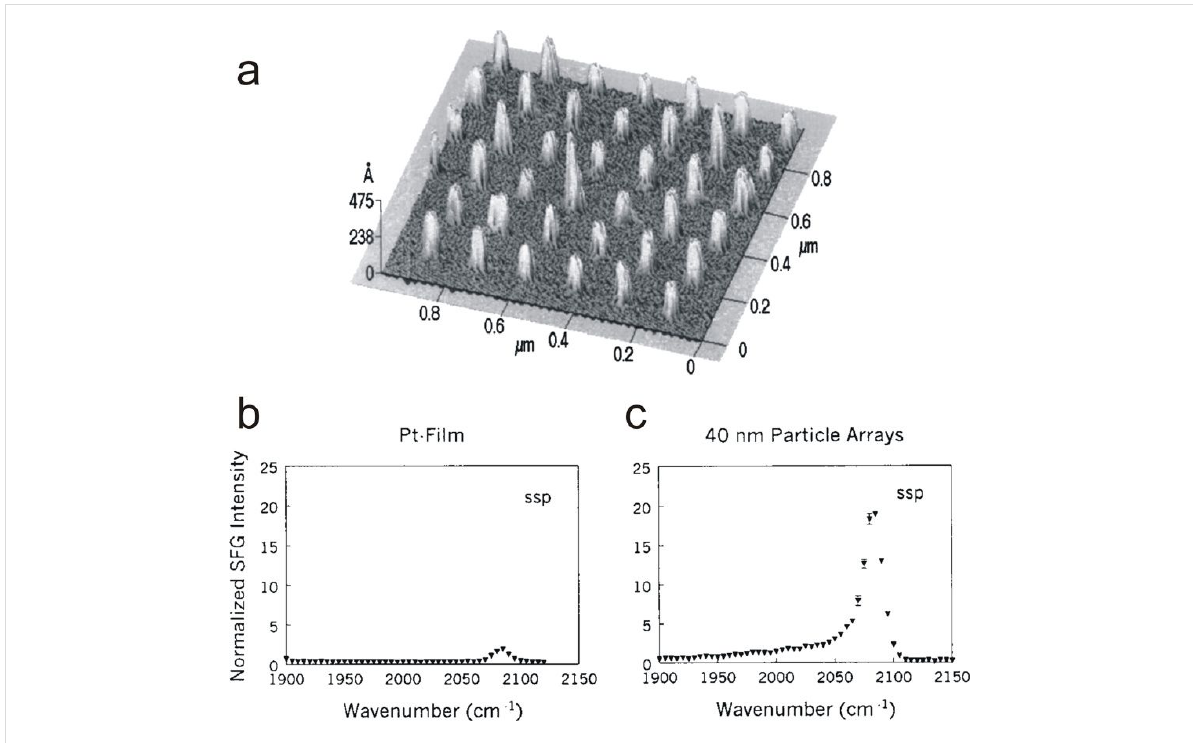
Figure 7: (a) AFM image of the platinum nano-antenna array, the antennas sizing 40 nm in diameter and being spaced by 150 nm. SFG spectra in ssp polarization of CO adsorbed on (b) a smooth Pt film and on (c) 40 nm Pt nano-antenna arrays. Figure adapted with permission from [76], Copy- right 2000 AIP Publishing